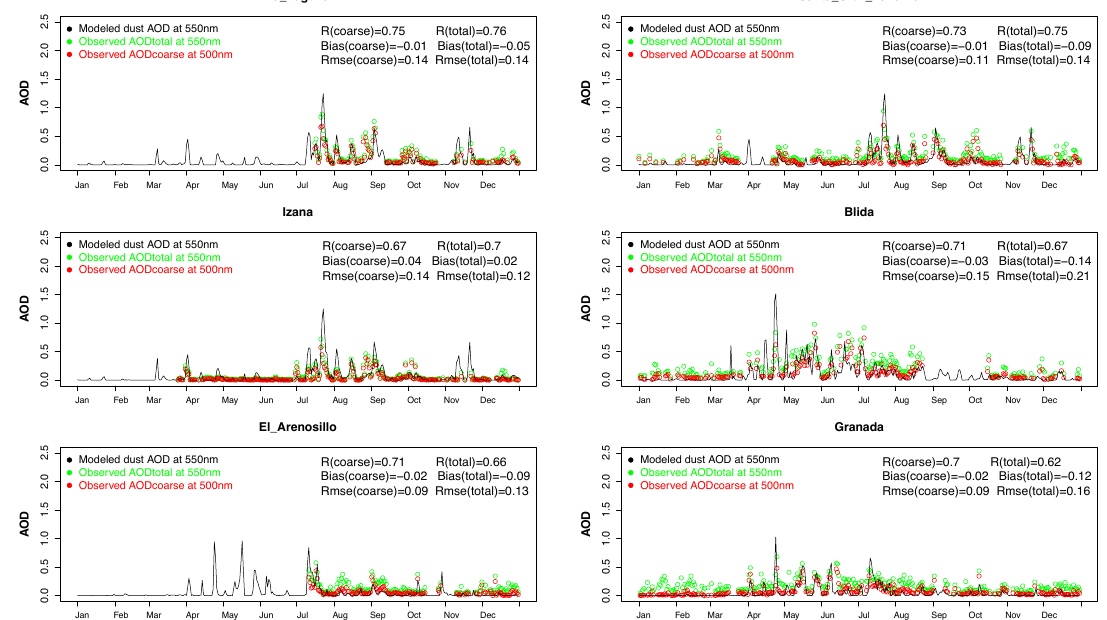
Fig. 7. Daily AOD average of model vs. AERONET stations in the Eastern Subtropical Atlantic (La Laguna, Santa Cruz de Tenerife and Izana), North Africa (Blida) and Iberian Peninsula (El Arenosillo and Granada) for 2006. Model averages (black lines) represent the dust AOD at 550nm. Observations include AODtotal (green circles) and AODcoarse (red circles). Each panel includes the correlation ( R ), bias and root mean square error (RMSE) between the model and AODcoarse and AODtotal. daily correlations are good and range from 0.52–0.59 in